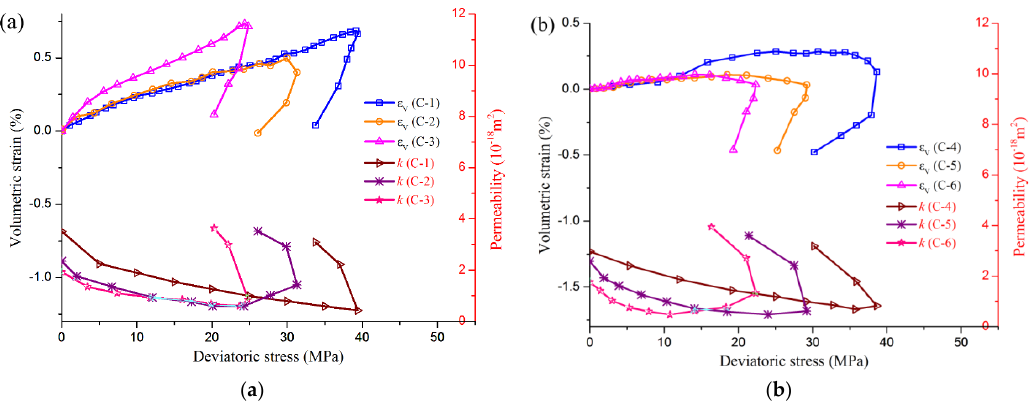
Figure 9. Relationship between volumetric strain, permeability and deviatoric stress of coal sample. ( a ) coal sample C-1, C-2 and C-3; ( b ) coal sample C-4, C-5 and C-6. 3.3. Influence of Mining-Induced Stress Paths on the AE Signal of Coal Samples Void collapse, crack growth and particle slip will occur with stress loading. The internal energy